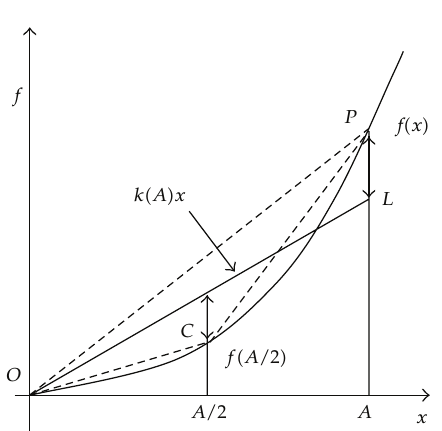
Figure 1: The geometric characterizing of the nonlinear restoring